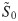
Different dynamical regimes for the mutualist-competitive system exist, depending on the values of the parameters.We define these regimes as follows: R1: Extinction. R2: Competitive exclusion, only species X1 survives. R3: Competitive exclusion, only species X2 survives. R4: bistability between extinction and coexistence. R5: bistability between survival of X1 and coexistence. R6: bistability between survival of X2 and coexistence. R7: coexistence of X1 and X2. (a) Influence of the growth rates μ in the chemostat system (b) Influence of the growth rates μ in the extended LV model (c) Influence of the flow rate Φ and the inflow S˜0 in the chemostat for μ = [1600, 800]. (d) Influence of the flow rate Φ and the inflow S˜0 in the extended LV model for r = [0.04, 0.02].